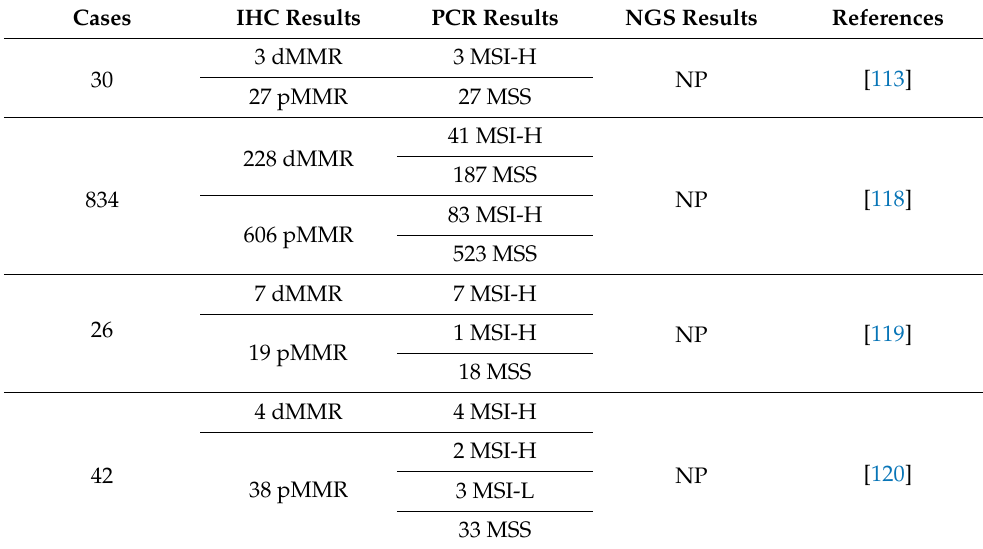
Table 5. Comparison between IHC, PCR and NGS in OC cases.